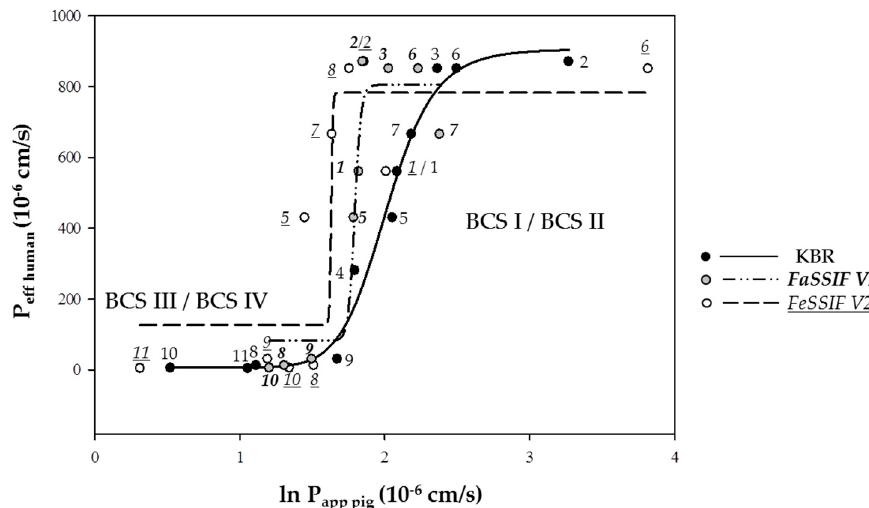
Figure 1. The correlation between the effective permeability coefficient in vivo, P eff,human (literature 132 values derived assuming smooth cylindrical representation of the surface area for absorption) and the 133 permeability coefficient calculated using porcine intestine ex vivo and the Ussing chamber technique 134 ( P app,pig ): The drug absorption was tested using KBR, and the biorelevant media, FaSSIF V2, and FeSSIF 135